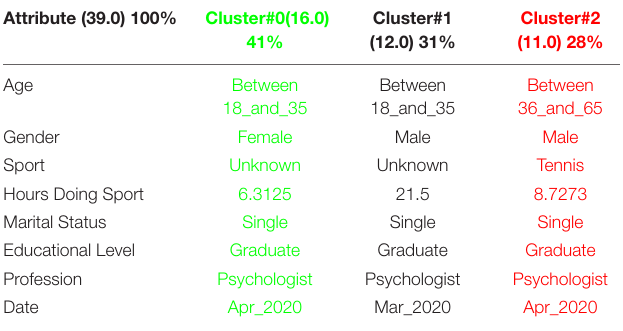
TABLE 8 | 3 clusters RS analysis for March to May